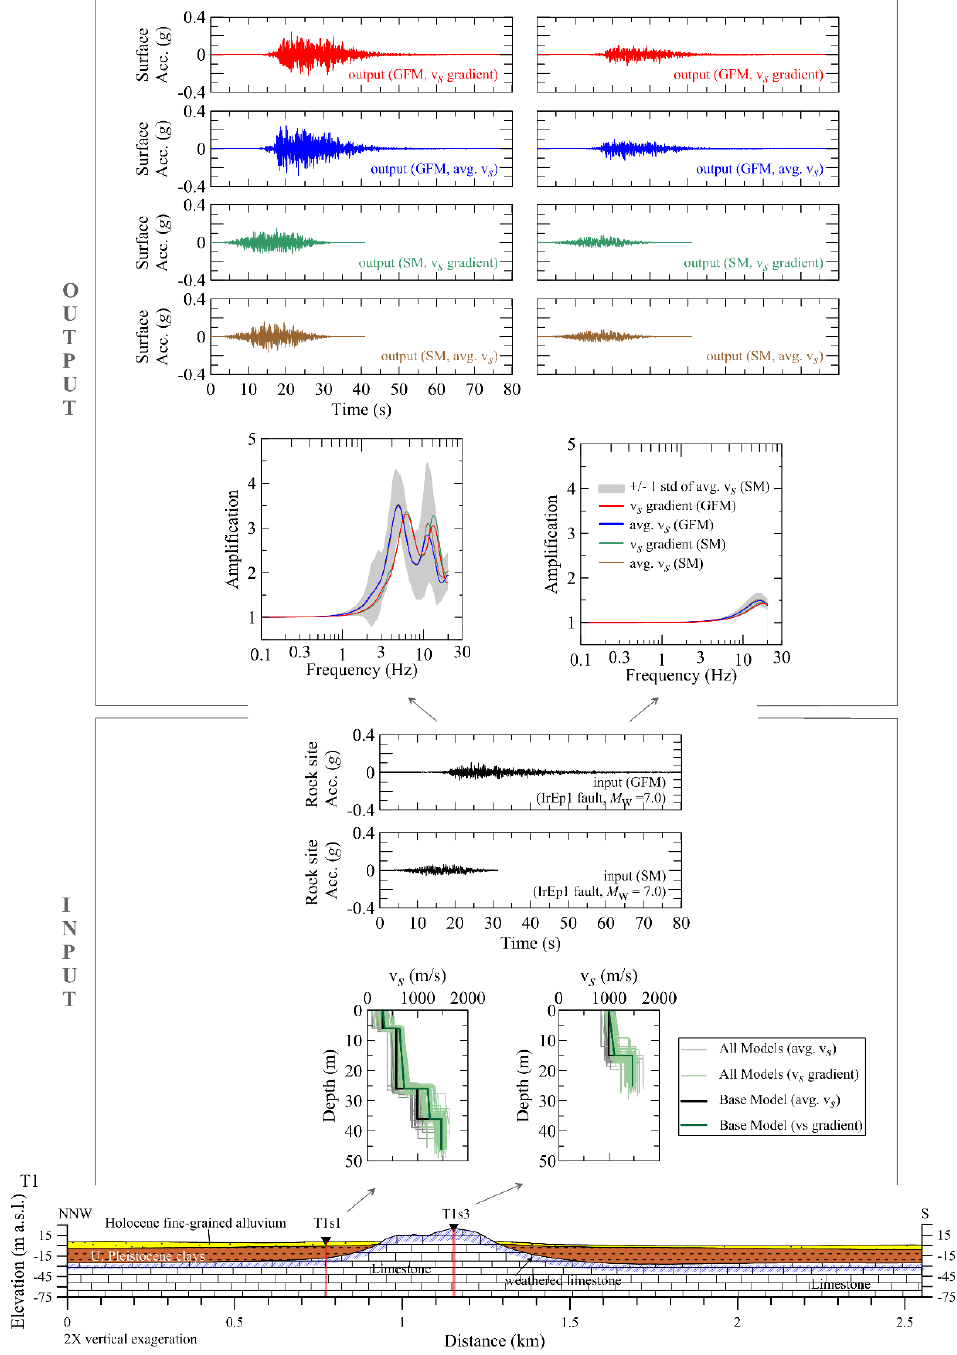
Figure 5. Example of four individual simulations using the Equivalent − Linear model for two 1D site-specific cases from a Late Bronze Age Greek archaeological site (Tiryns): a soil − site (T1s1) and rock-site (T1s3) highlighted by the vertical red bars located along the geologic profile (lower panel). For one simulation, the input consists of one modeling site (e.g., T1s1 or T1s3) represented in two ways: by an average V s model and a gradient V s . Each case is accelerated with a synthetic accelero- gram calculated with the Stochastic method (SM) and a synthetic accelerogram calculated with Green ’ s function method (GFM) (middle panel). The synthetic accelerograms correspond to a local strike-slip earthquake ( M w = 7.0) triggered by the nearby Iria − Epidaurus fault segment. The output yields a computed site − specific surface acceleration record and a site − specific seismic amplification function (upper panel). Used with permission from [18]. Copyright 2016, Hinojosa − Prieto, H.R.